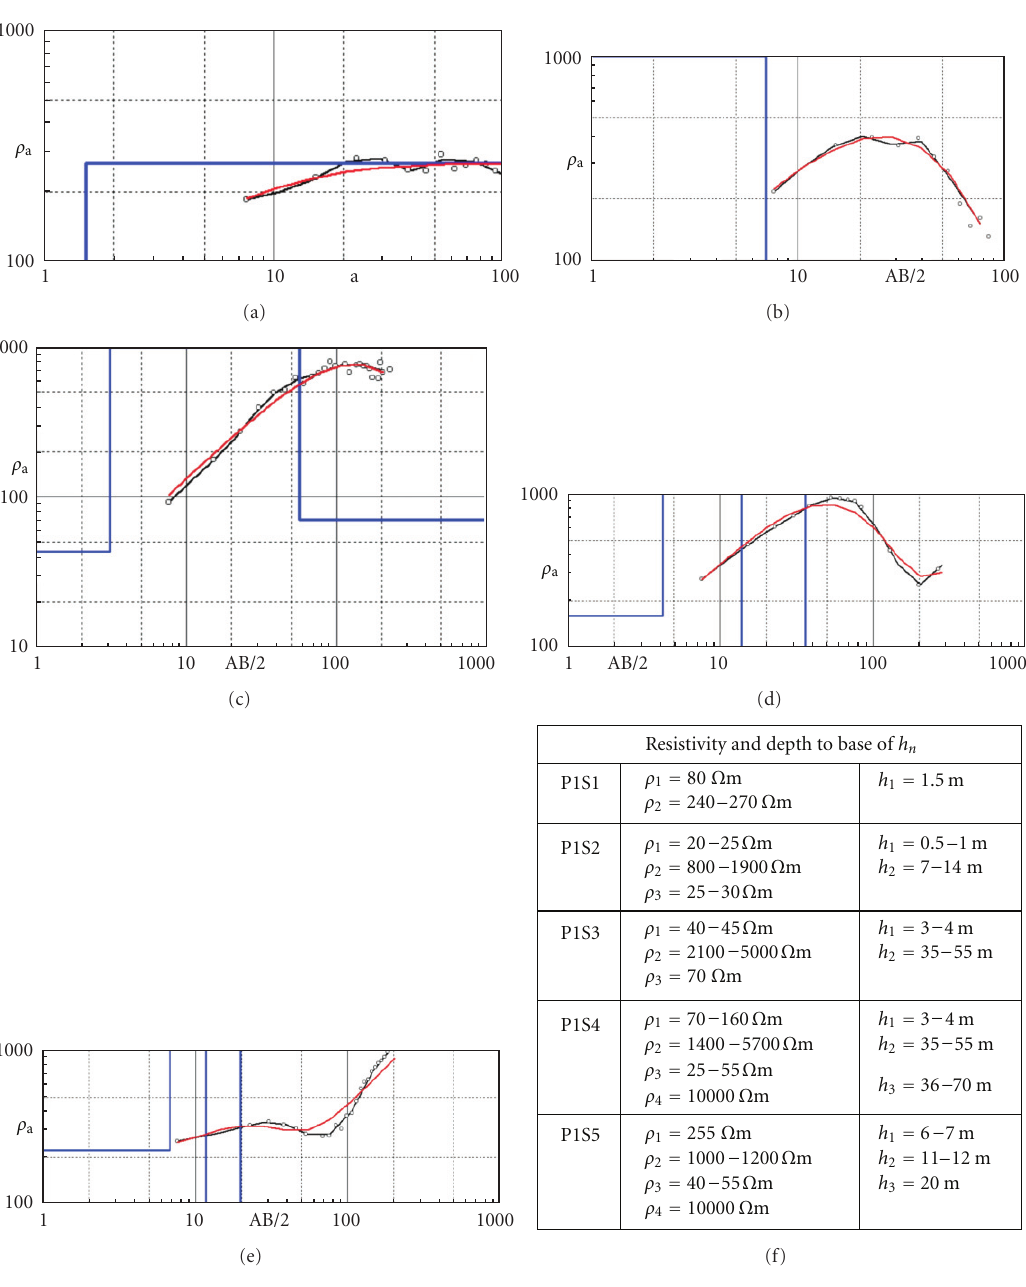
Figure 4: Inversion models for soundings 1 to 5 are shown in (a) to (e). (a) Sounding P1S1, (b) Sounding P1S2, (c) Sounding P1S3, (d) Sounding P1S4, and (e) Sounding P1S5. X -axis represents distance in meters and Y -axis represents resistivity in Ohm-m. In the graphs, the black line represents the observed data, blue line represents the inverse model, and the red line represents the calculated response from the inverse model. (f) Interpreted resistivities and layer thicknesses for the five electrical